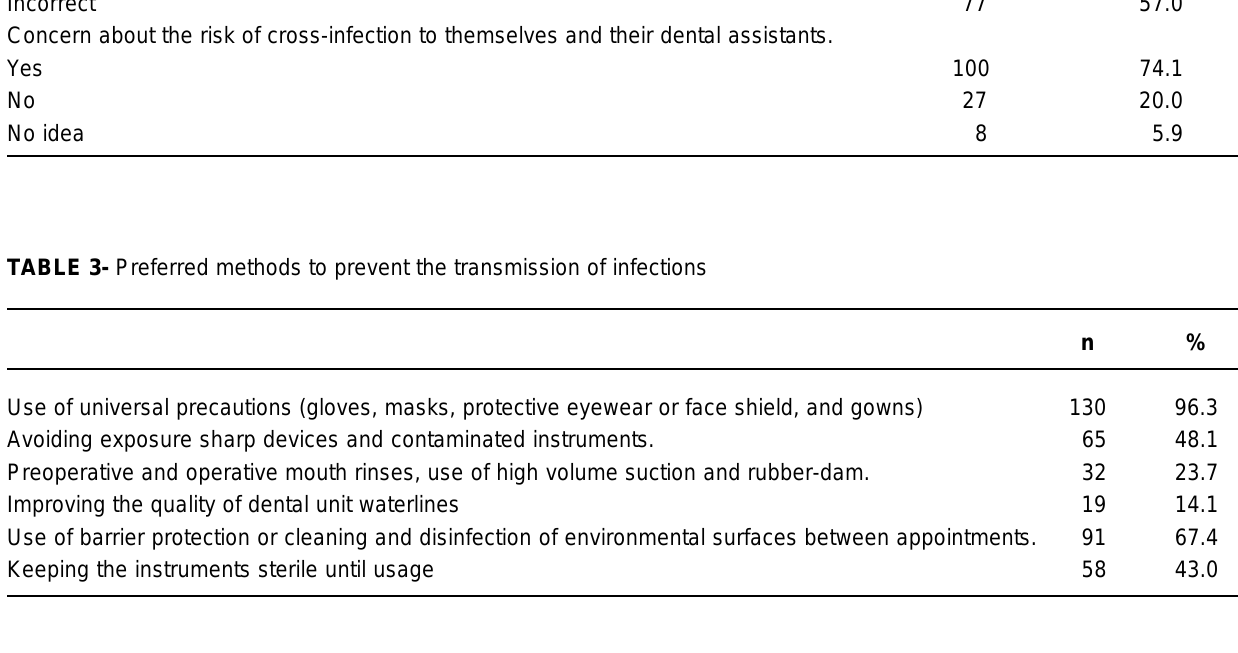
Avoiding exposure sharp devices and contaminated instruments. Improving the quality of dental unit waterlines